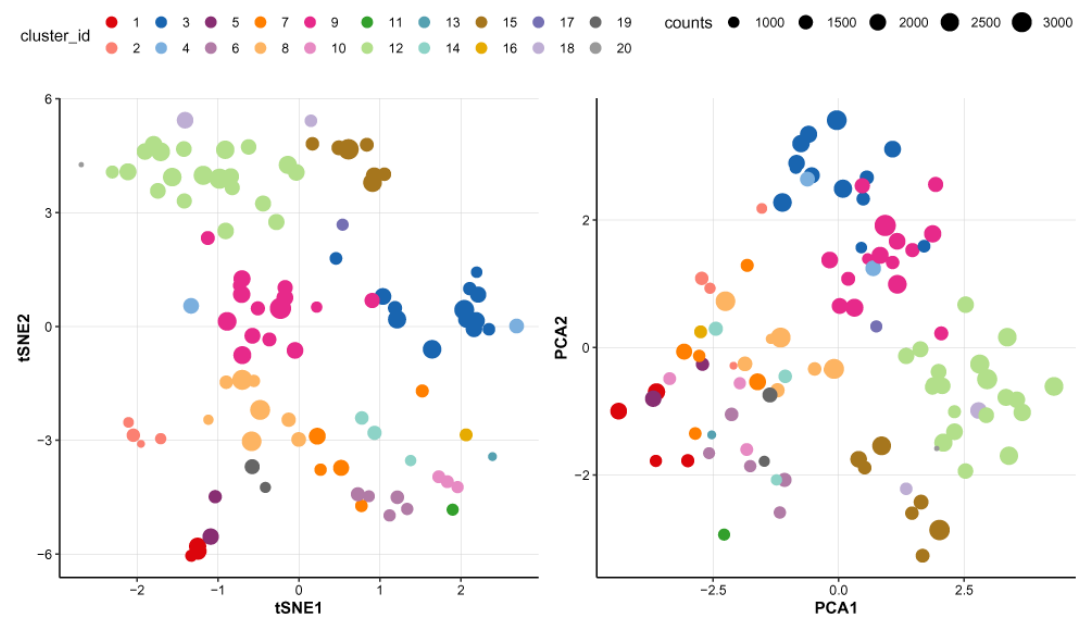
Figure 13. The 100 SOM codes in the PBMC dataset colored according to the metaclustering with ConsensusClusterPlus into 20 cell populations presented after the dimension reduction with ( A ) t-SNE and ( B ) PCA. The SOM codes represent characteristics of the 100 (by default) clusters generated in the first step of the FlowSOM pipeline. The size of the points corresponds to the number of cells that were assigned to a given code.